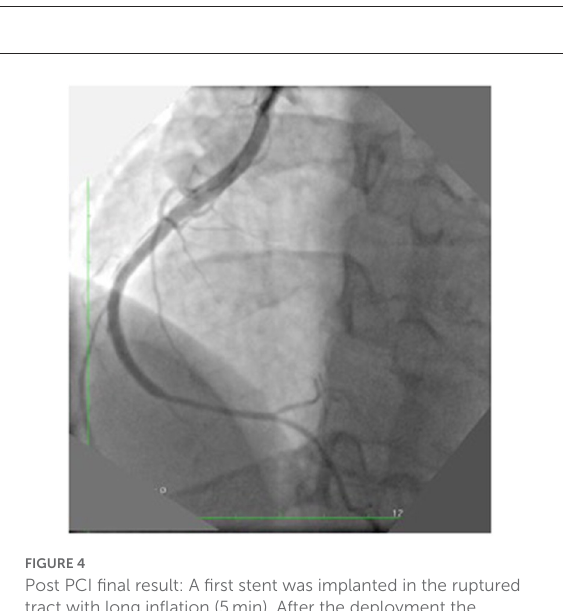
FIGURE4 Post PCI final result: A first stent was implanted in the ruptured tract with long inflation (5min). After the deployment the effusion disappeared. Four additional stents were implanted to cover the dissection. The final angiography showed a good